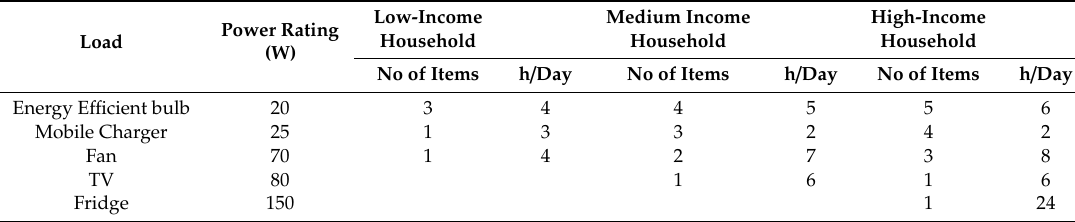
Table 5. Average energy load of di ff erent types of residents living in the projected